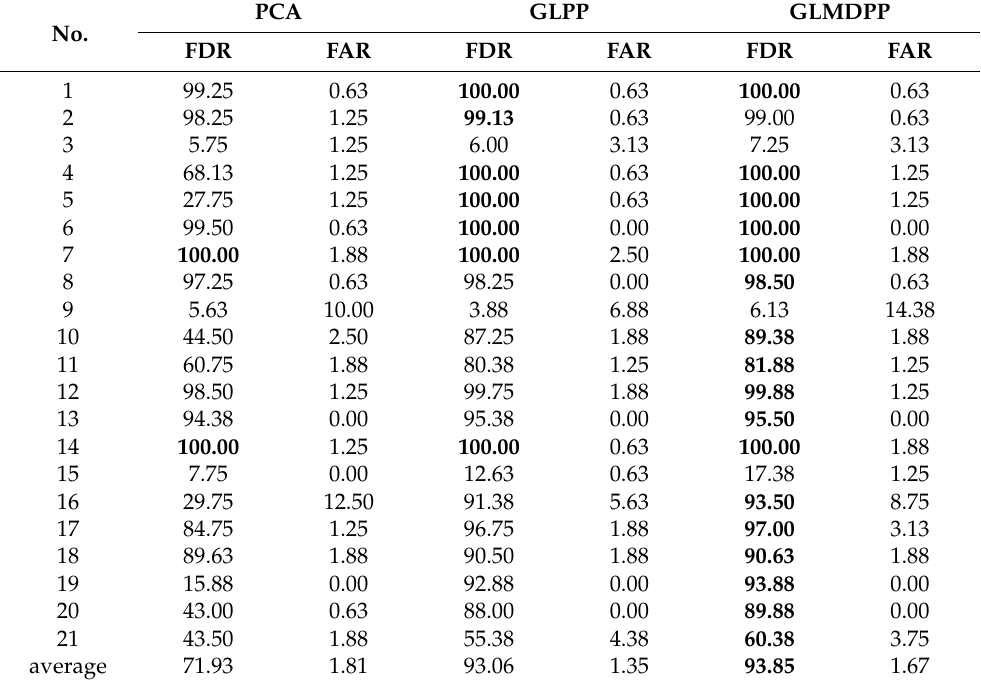
Table 3. FDRs (%) and FARs (%) of different method on TE process.